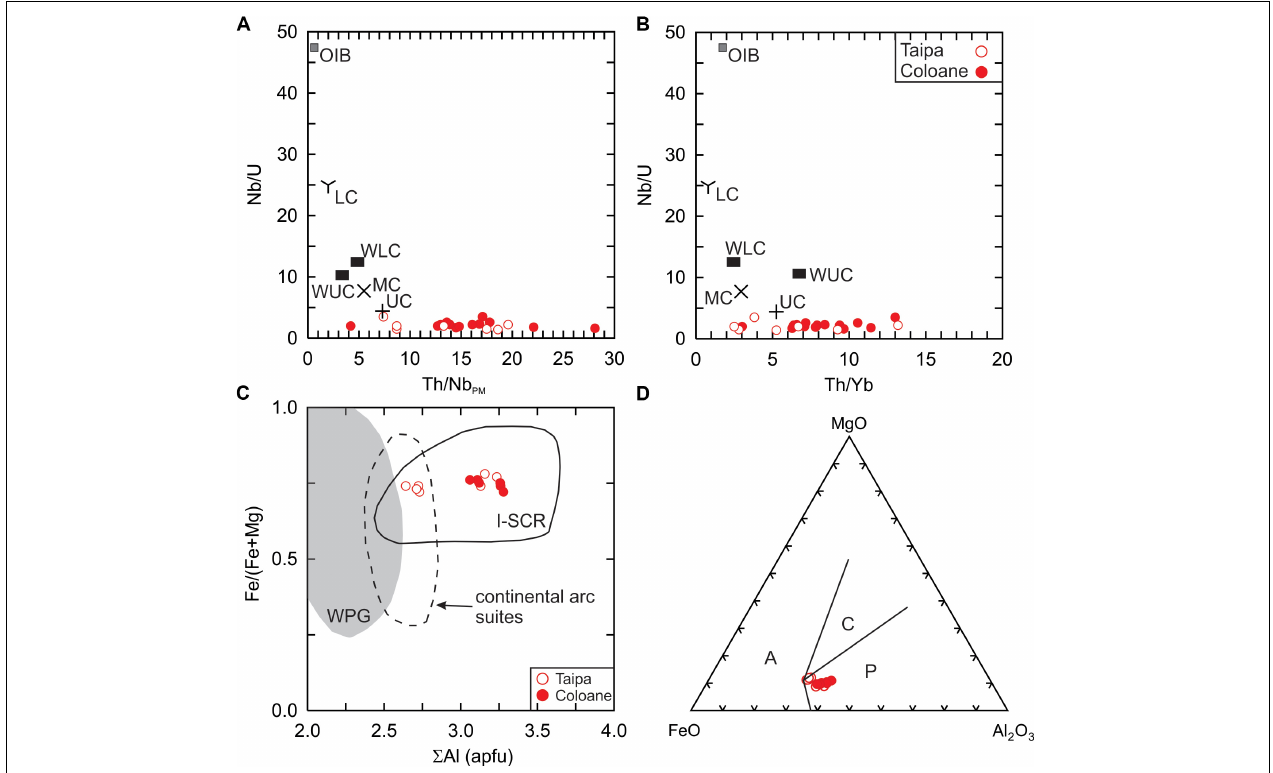
FIGURE 9 | (A) Nb/U vs. Th/NbPM and (B) Nb/U vs. Th/Yb of the Taipa and Coloane leucogranites. PM = primitive mantle normalized. UC = upper crust, MC = middle crust, LC = lower crust of Rudnick and Gao (2003). WUC = upper crust of Wedepohl (1995), WLC = lower crust of Wedepohl (1995). OIB = ocean-island basalt of Sun and McDonough (1989). (C) Composition of biotite from the Taipa and Coloane leucogranites expressed as Fe/(Fe+Mg) vs. total (S) Al (apfu) with respected to biotite from within-plate (A-type) granites, continental arc suites, and strongly contaminated and reduced I-type (I-SCR) granites